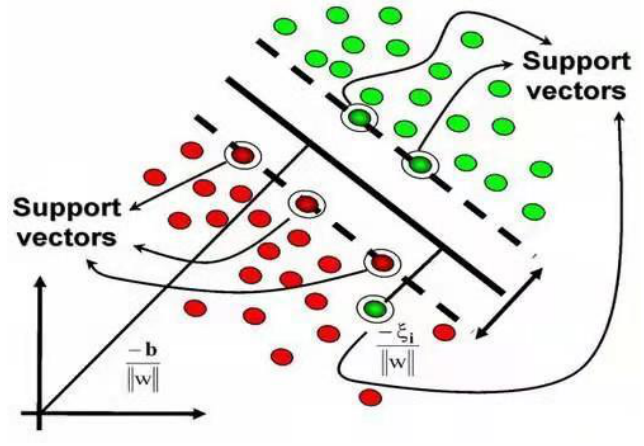
Figure 2. Linear SVM scenario.